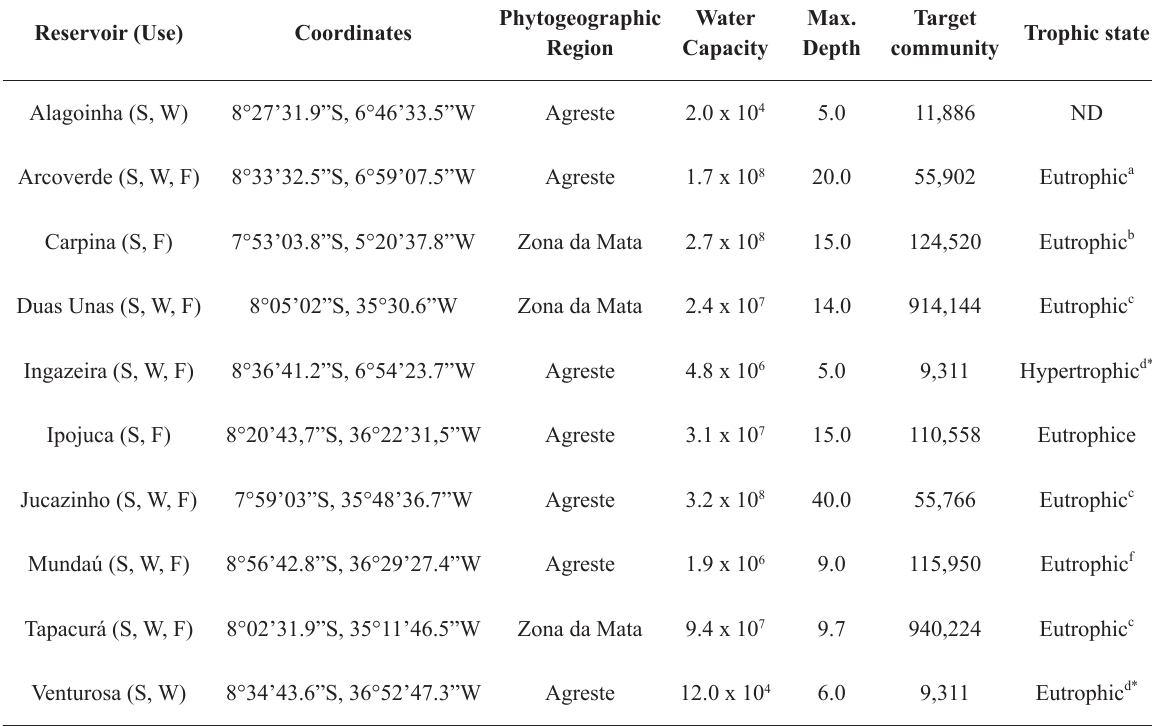
Reservoirs, coordinates, use, phytogeographic region, water capacity (m 3 ), maximum depth